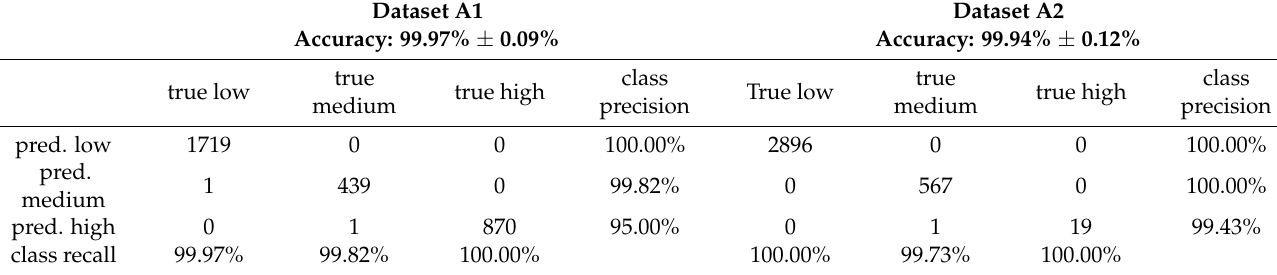
Table 2. Confusion matrix with the classification generated with algorithm RF and datasets A1 and A2. A contrast between the classifications obtained with the datasets above is shown, along with accuracy, recall, and class-precision values for both matrices.